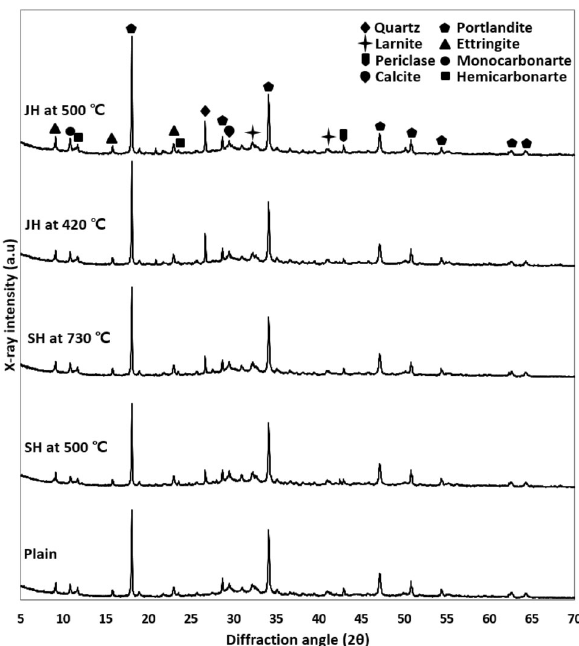
Fig. 6 XRD patterns of 28 day old cement paste (plain) and 10 wt% replacement of heat treated dredged sea soil (w/b = 0.5).